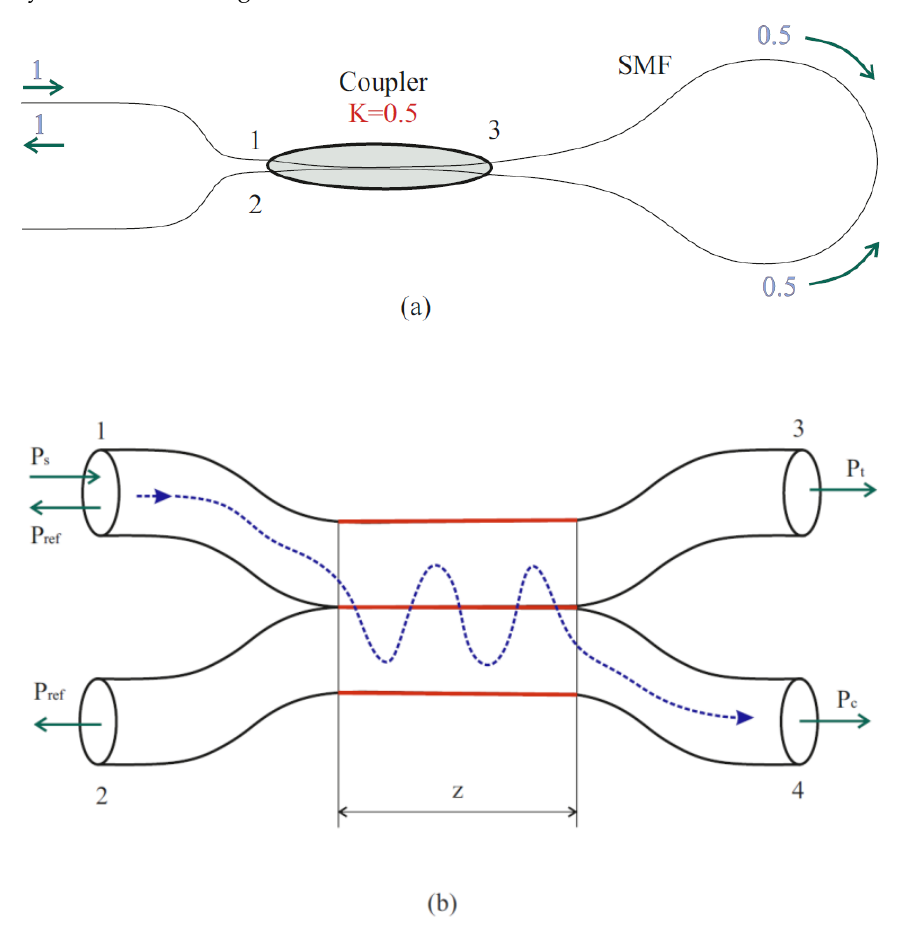
Figure 22. Scheme of a fiber loop mirror and its principle of operation: ( a ) scheme of a fiber loop mirror and ( b ) propagation of radiation in a fiber splitter.